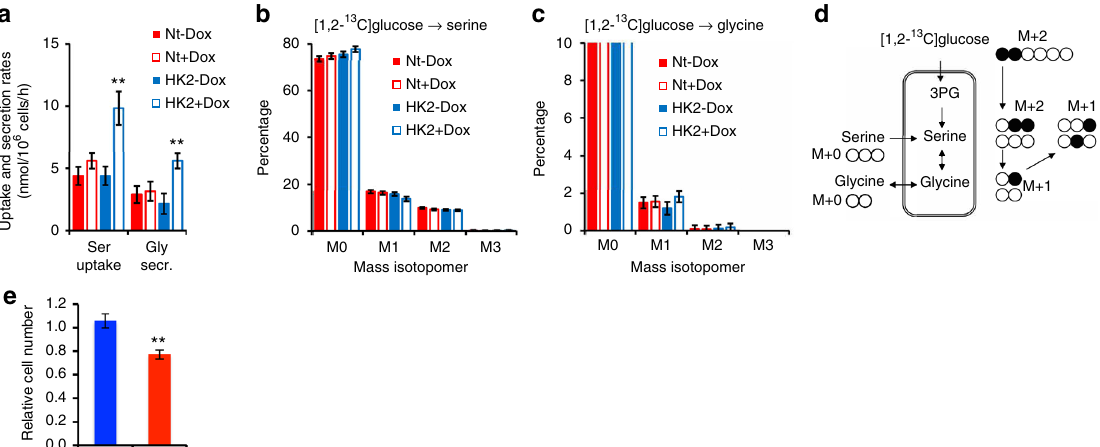
Fig. 5 Changes in serine metabolism by HK2 loss. a Changes in extracellular serine uptake and glycine secretion after inducible HK2 KD (HK2 + DOX). b Tracing of [1,2- 13 C]glucose to serine. c Tracing of [1,2- 13 C]glucose to glycine. d Schematic showing [1,2- 13 C]glucose /serine/glycine tracing and serine/ glycine exchange. All data represent the mean ± SD, ** p < 0.001 by Welch ’ s unequal variances t-test. e Cell proliferation after inducible HK2 KD (HK2sh) or control (Ntsh) Huh7 cells in the presence or absence of serine. Cells were exposed to Dox for 4 days prior to analysis and maintained in Dox throughout the analyses. Bar graph shows relative cell number after 6 days of growth in serine-free media compared to cell number in complete media. The results represent mean ± SEM of two different experiments in triplicate, ** p < 0.01 by Student ’ s t